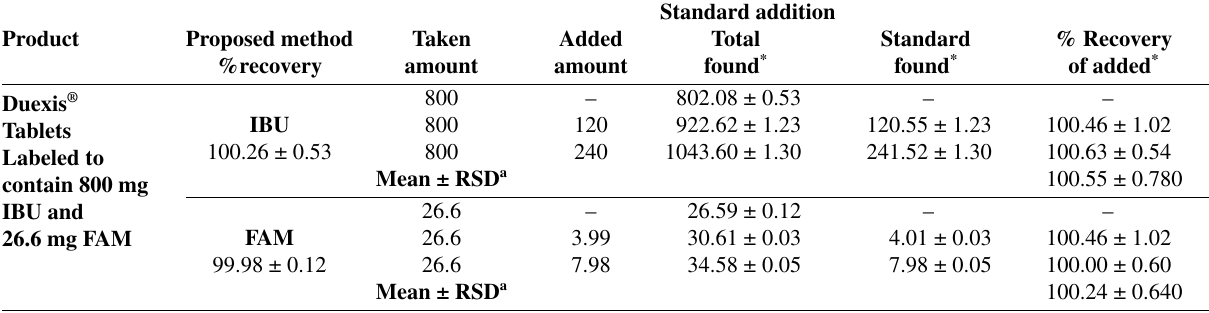
Table 3. Analysis of IBU and FAM in marketed formulations by HPLC method and application of standard addition technique